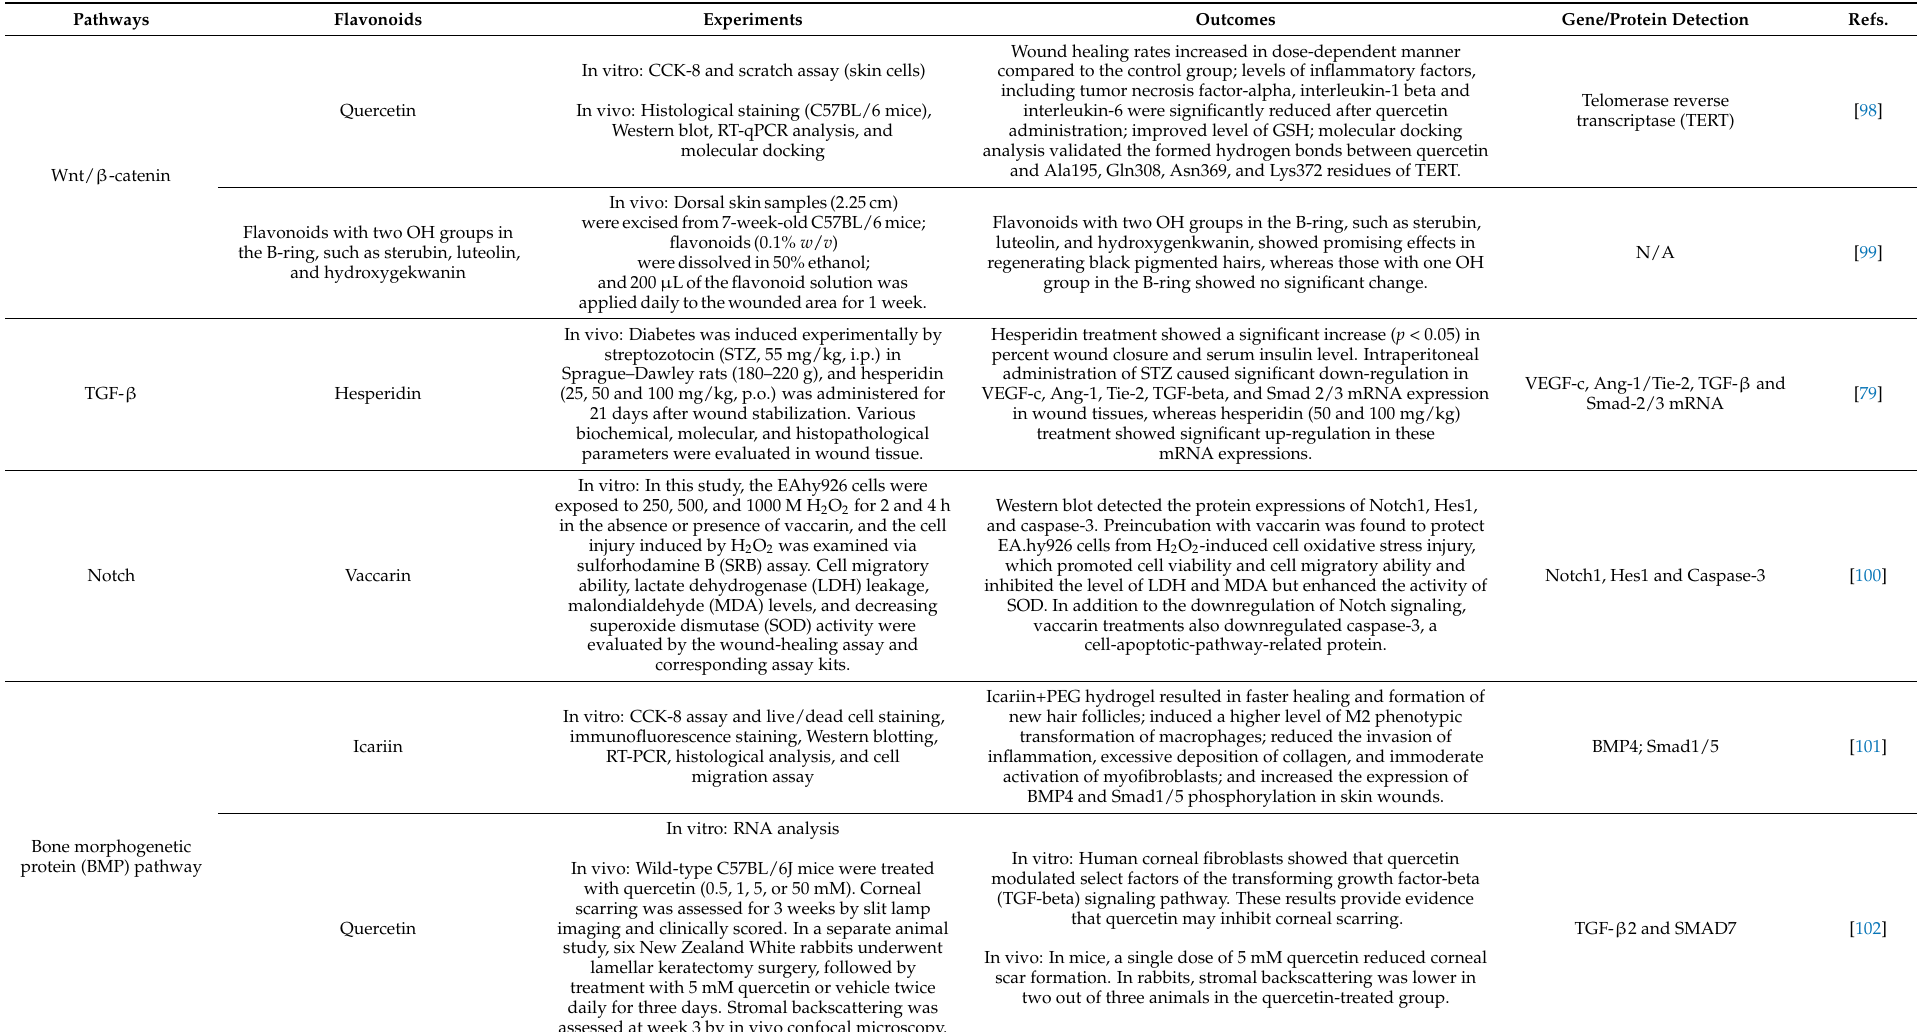
Table 4. Wound healing effects of flavonoids according to respective